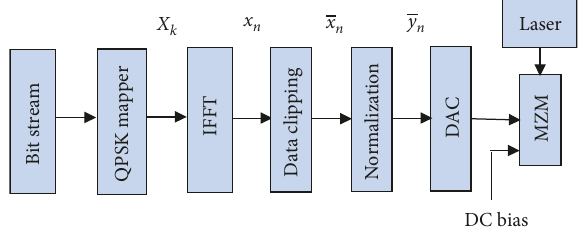
Figure 1: Block diagram of the proposed OFDM